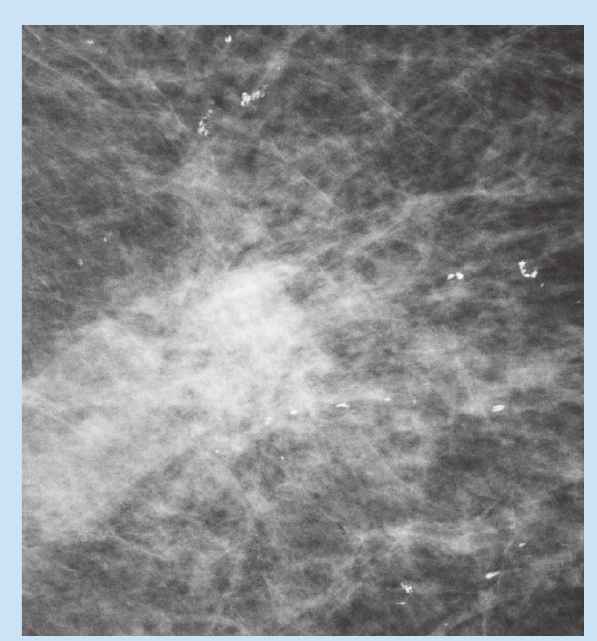
Fig. 4. Patient 4 – scattered punctuate, linear and amorphous calcifications (with mass); calcification pattern is benign.